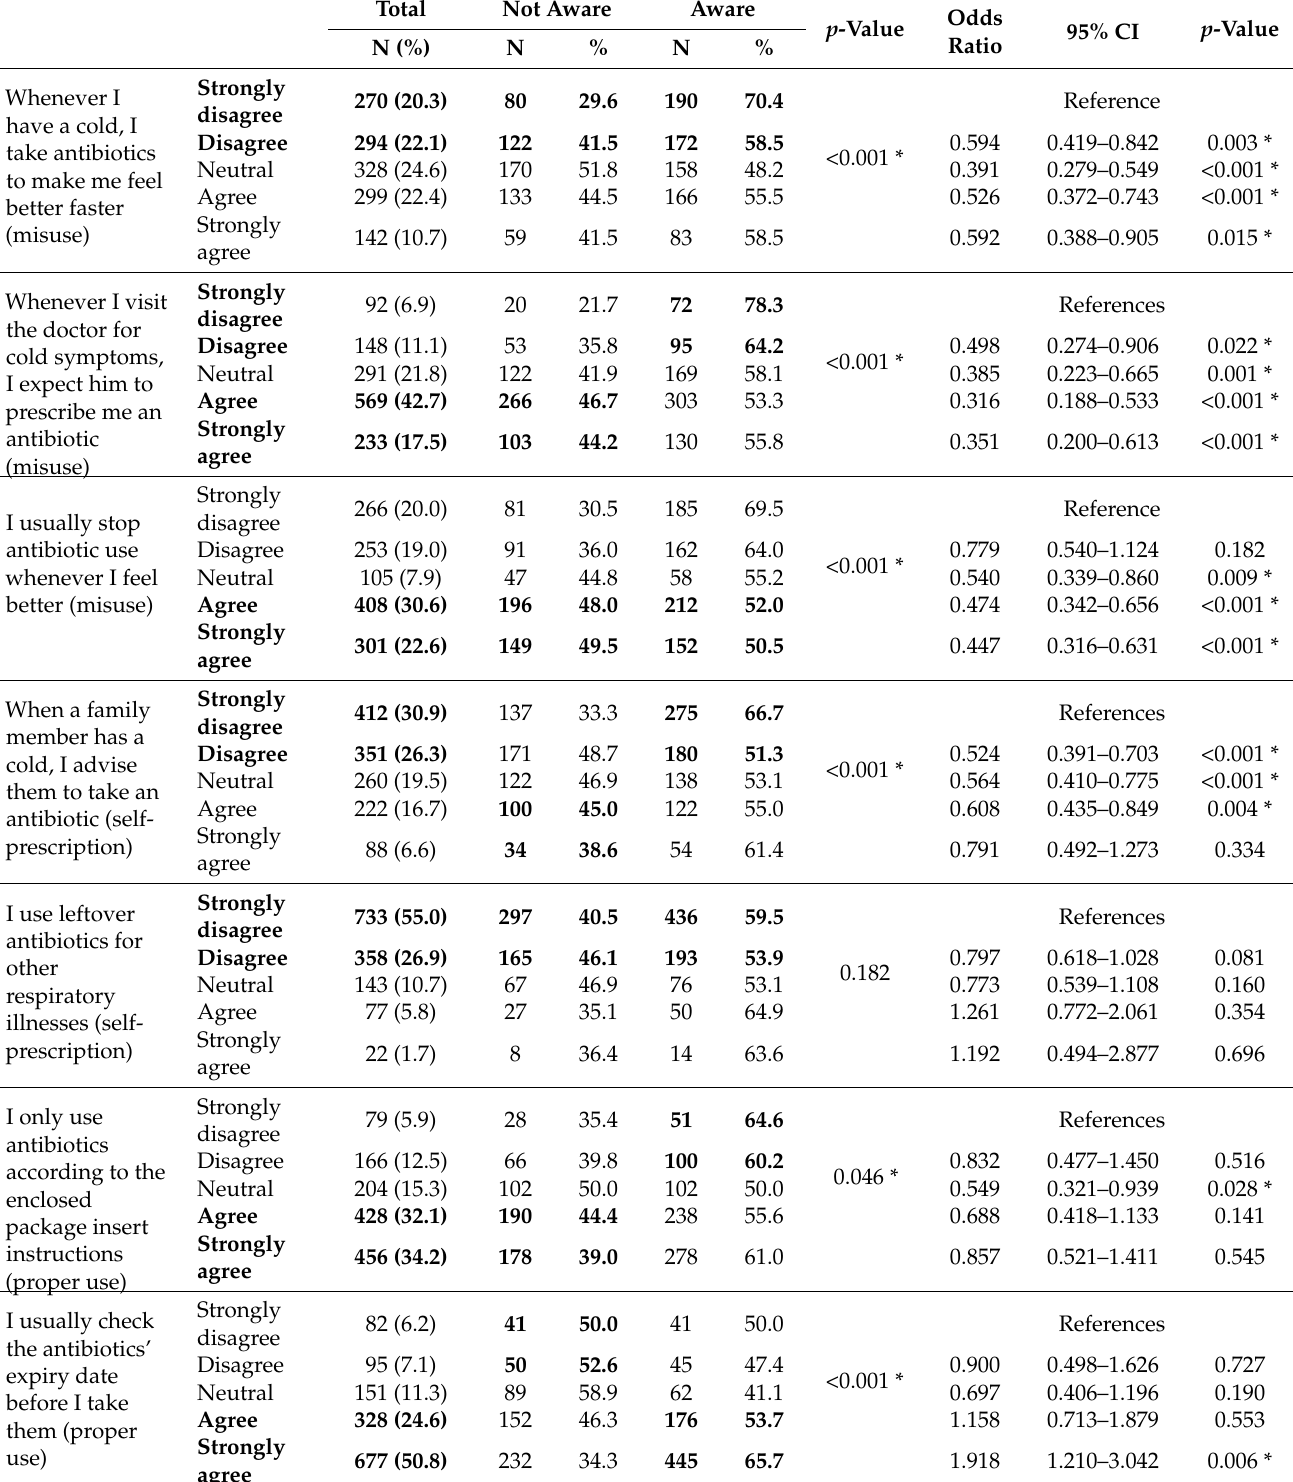
Table 3. Survey participant knowledge and attitudes toward proper AB use stratified by an assess- ment of their awareness of the MOH AB policy using bivariate analysis and odds ratios calculated via binary logistic